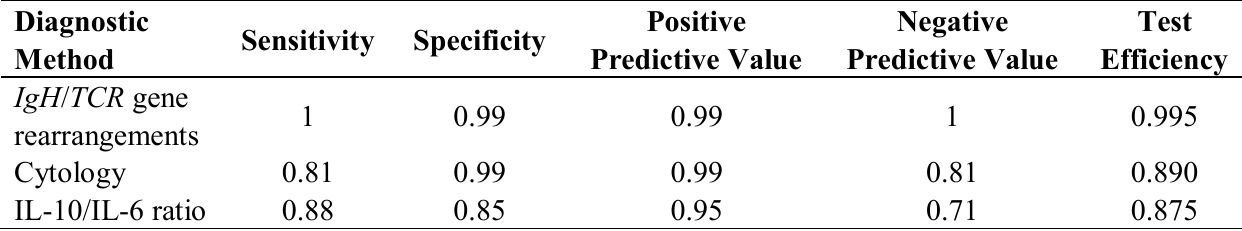
Table 7. Comparison of the diagnostic value in molecular, cytological, and cytokine